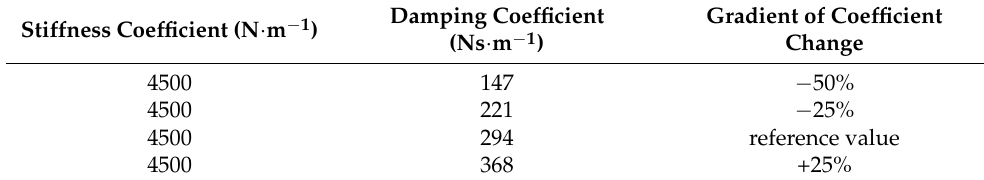
Table 2. Simulation parameters of damping value with large heave motion.